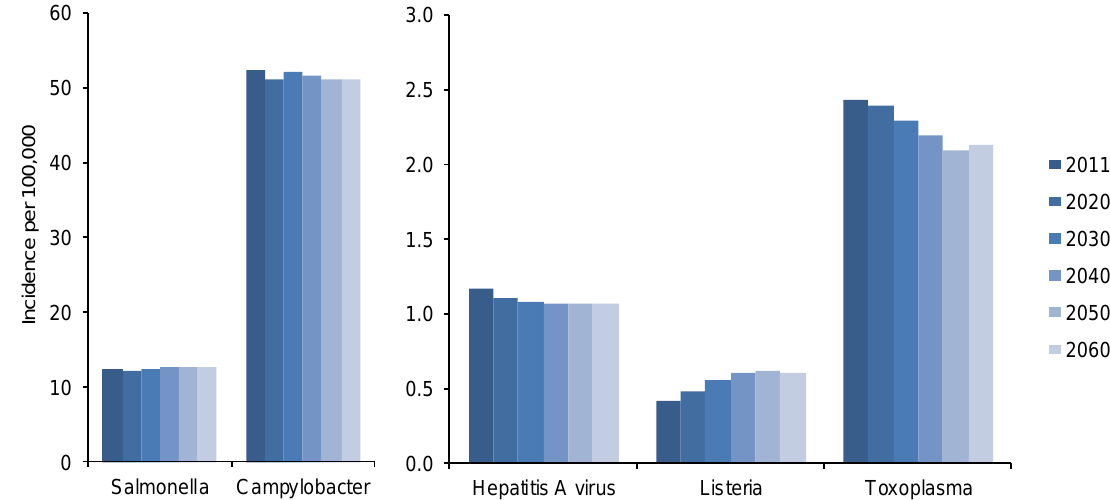
Figure 2. Estimated annual incidence per 100,000 population for five foodborne pathogens until 2060. The changes depicted are based on changes in population buildup regarding age as independent